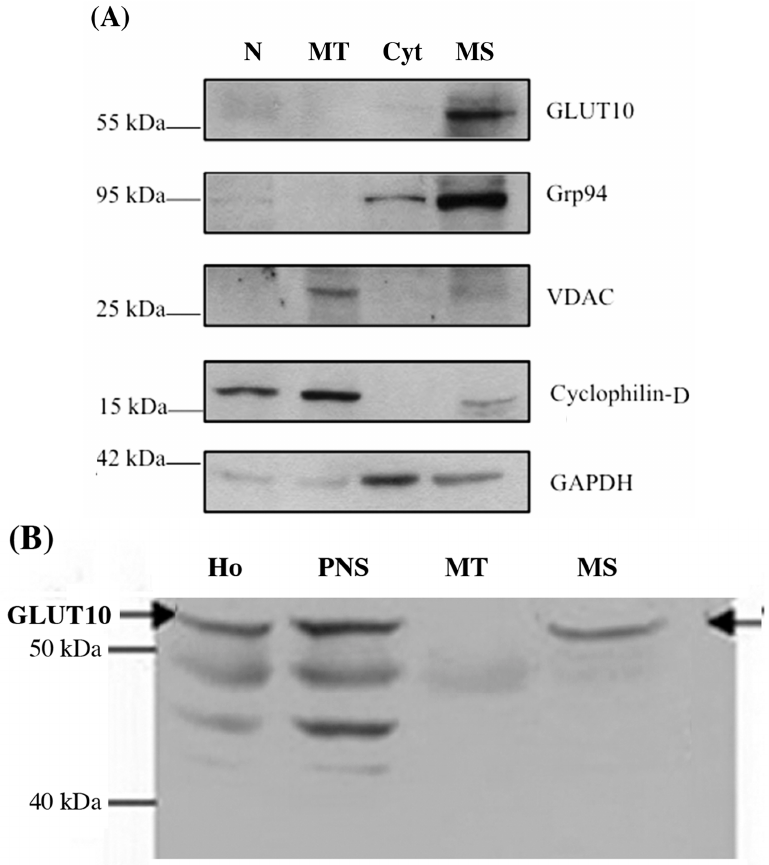
Figure 1. GLUT10 is present in the microsomal fraction of human fibroblasts and liver tissue. Subcellular fractions were prepared from human skin fibroblasts ( A ) or human liver tissue ( B ) and analyzed by Western blot after SDS-page separation of proteins, with antibodies to the GLUT10 protein as well as the marker proteins Grp94 for microsomes, VDAC1 and cyclophilin D for mitochondria, and GAPDH for the cytosol, as detailed in the “Experimental” section. Abbreviations: N: Nuclei; MT: mitochondria; Cyt: cytosol; MS: microsomes; Ho: homogenate; PNS: post nuclear supernatant.